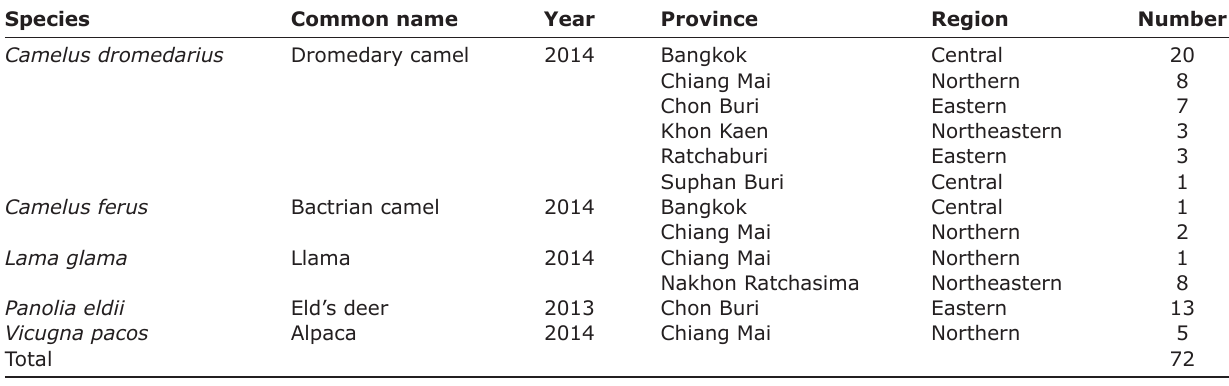
Table-1: Demographic characteristics of archival sera derived from four camelid species and Eld’s deer living in different zoos in Thailand.